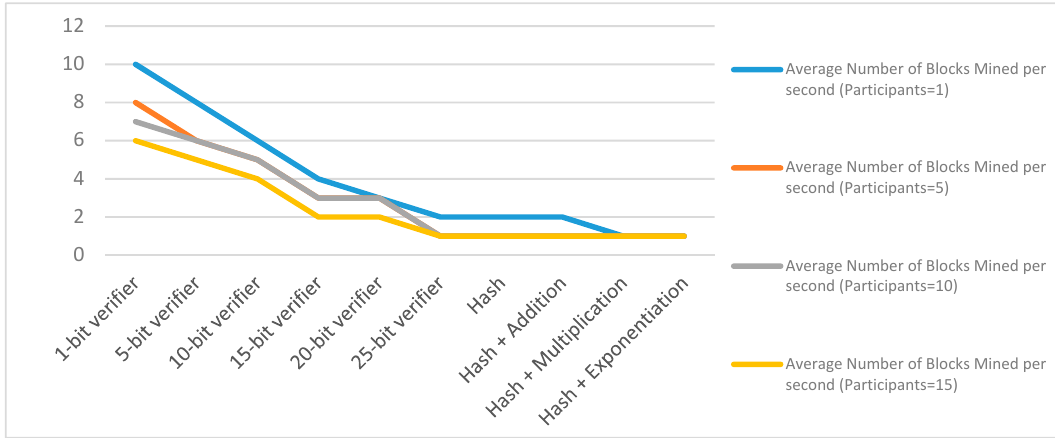
Figure 31. Comparative analysis of change in the number of blocks mined per seconds with a change in block challenges.